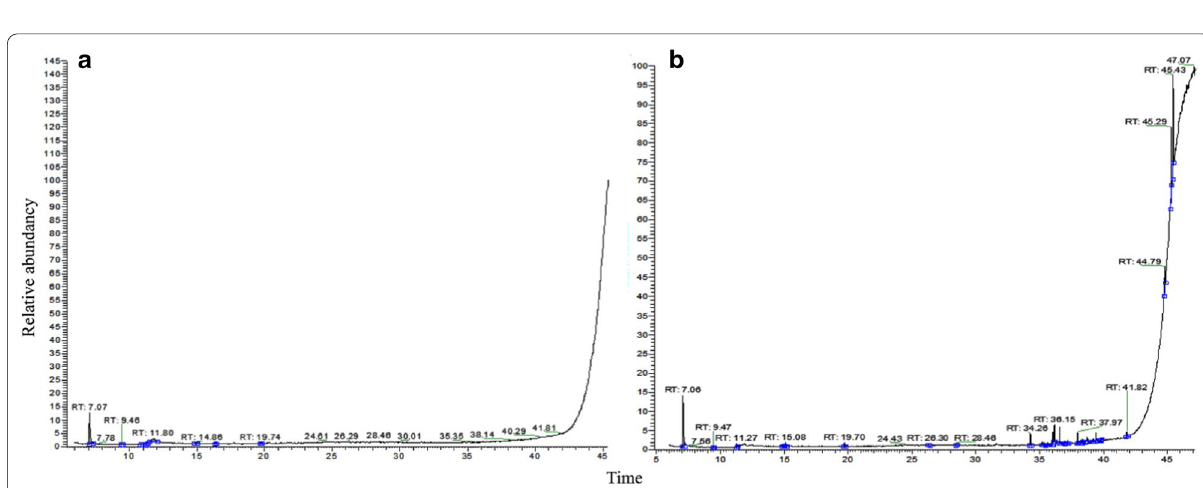
Fig. 4 Chromatograms of the bioactive compounds present in a hot, and b cold acetone extracts of simarouba